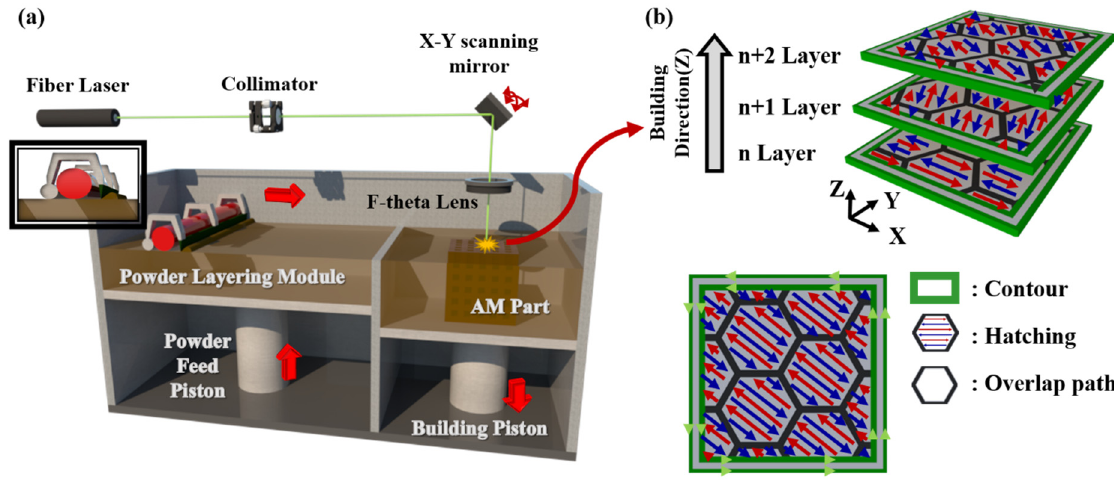
Figure 3. Schematic of ( a ) L-PBF machine and ( b ) strategies of laser scanning and layering.